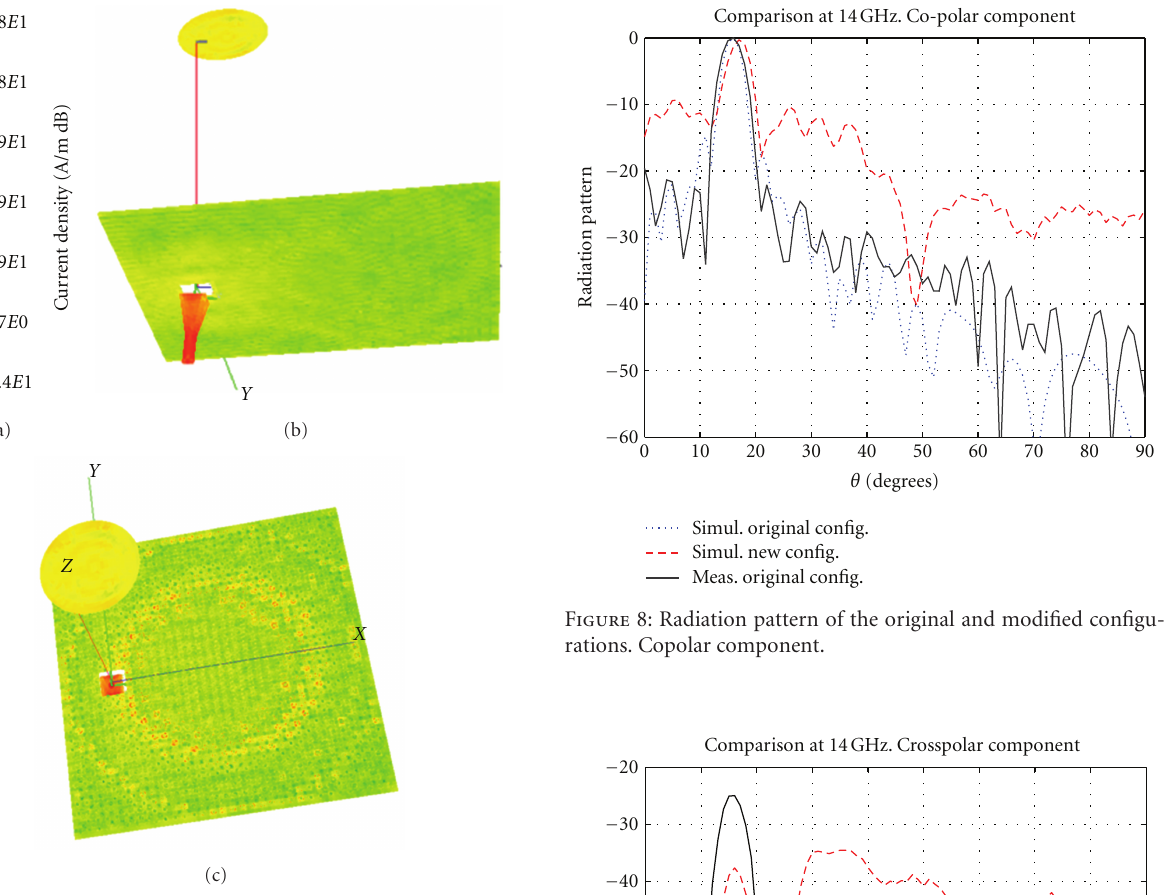
Figure 7: Current distribution.